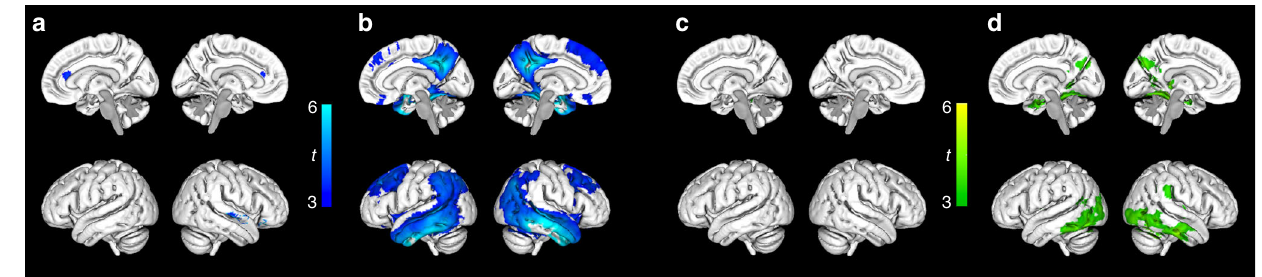
Fig. 4 Group comparisons of annual change in brain volume and glucose metabolism in ADNI. a Voxel-based morphometry (VBM) comparison of annual MRI change over 2 years in early A β accumulators (CSF+/PET − , n = 59) compared with non-accumulators (CSF − /PET − , n = 218). The results are adjusted for age, gender, and intracranial volume. The contrast is reduction in cortical thickness in early compared with non-accumulators and shows no clear pattern of longitudinal atrophy in the early A β accumulators (CSF+/PET − ). b The same VBM analysis as in a , but with a comparison between non- accumulators and late A β accumulators (CSF+/PET+, n = 191). The contrast is reduction in late compared with non-accumulators and shows a typical AD atrophy pattern in the non-demented late A β accumulators (CSF+/PET+). c Voxelwise analysis of annual FDG PET change over 2 years in non- accumulators ( n = 153) compared with early A β accumulators ( n = 41). No signi fi cant difference is seen. d The same FDG PET analysis as above, but with a comparison between non-accumulators and late A β accumulators ( n = 124). The contrast is reduction in glucose metabolism in late compared with early A β accumulators and shows a temporal and to a lesser extent parietal reduction in metabolism in the non-demented late A β accumulators. Voxelwise two- sample t -tests were used and all results in a – d were adjusted for age and gender. The VBM analysis was also adjusted for total intracranial volume. Only voxels with a p < 0.001 are shown. The colors illustrate signi fi cant t values according to the scales